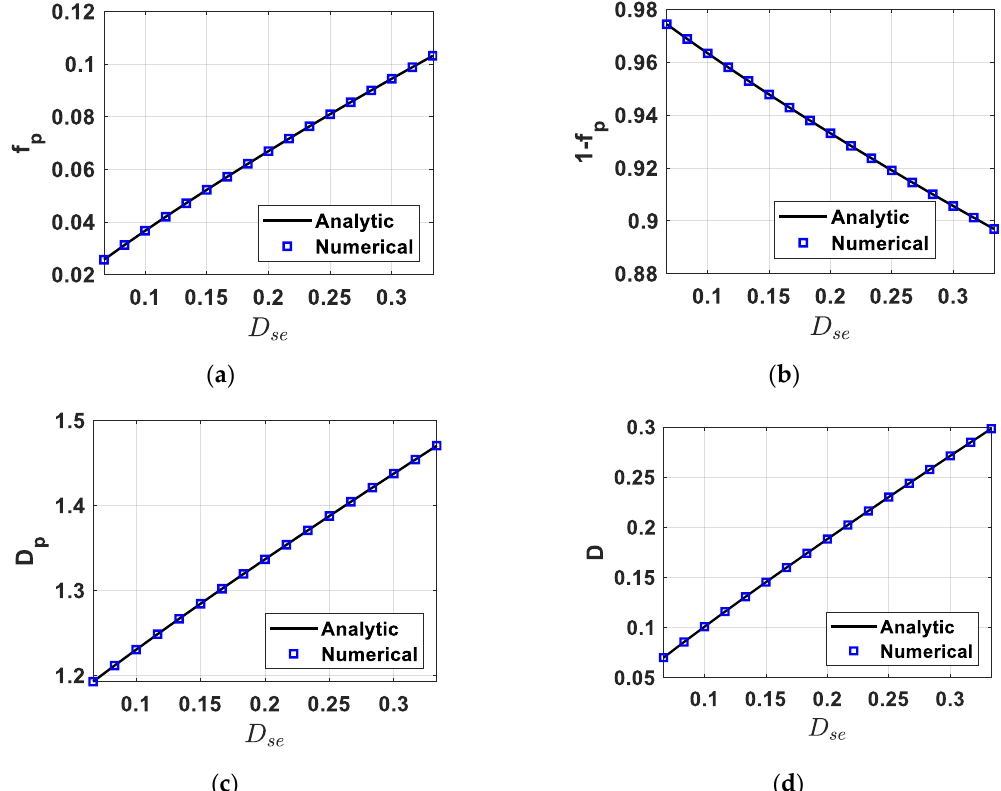
Figure 2. Analytical solutions from Equation (22) (Section 3.1) and numerical solutions from Equation (23) are shown for biexponential model parameters ( a ) f p , ( b ) 1- f p , ( c ) D 0 , and ( d ) D, as functions of the stretched exponent 𝐷 𝑠𝑒 , both for 𝑏 = 0, 1, 2, 3 and 𝛼 ̂ = 0.9 .